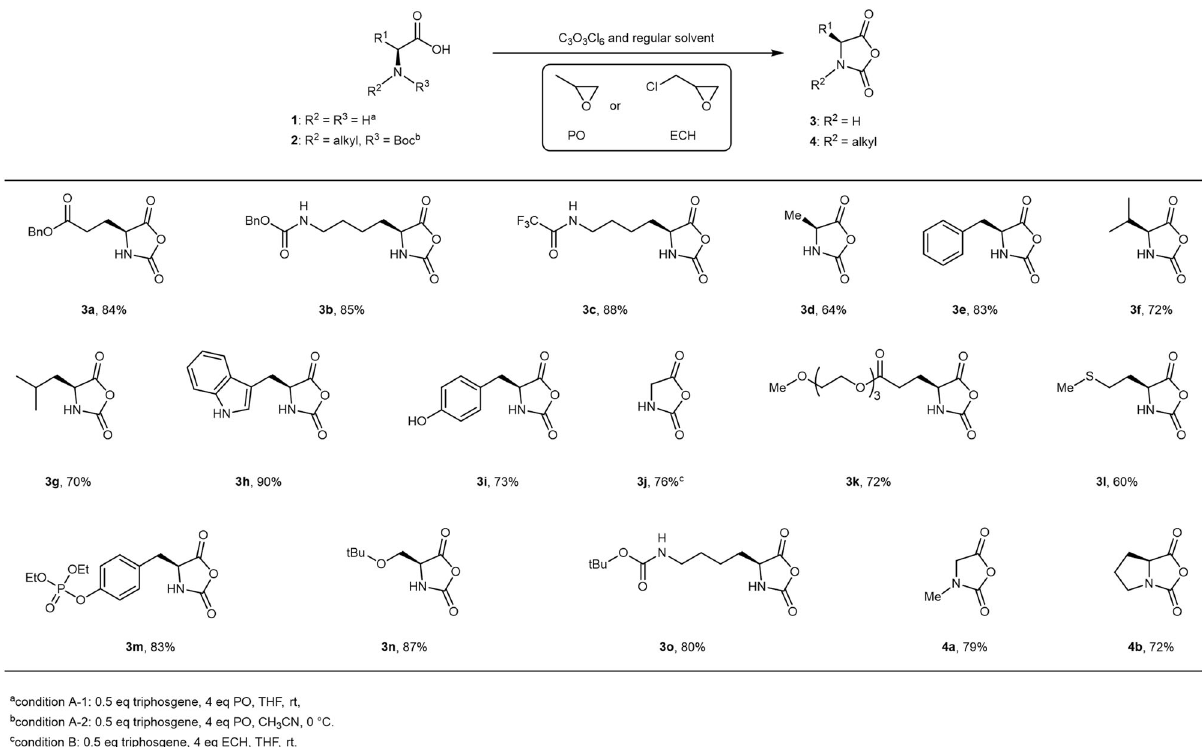
Fig. 3 Synthesis of NCAs with protected or unreactive side chains. The addition of PO (propylene oxide) or ECH (epichlorohydrin) enables the facile synthesis of NCAs without the need of dry solvents, Schlenk line, or glove